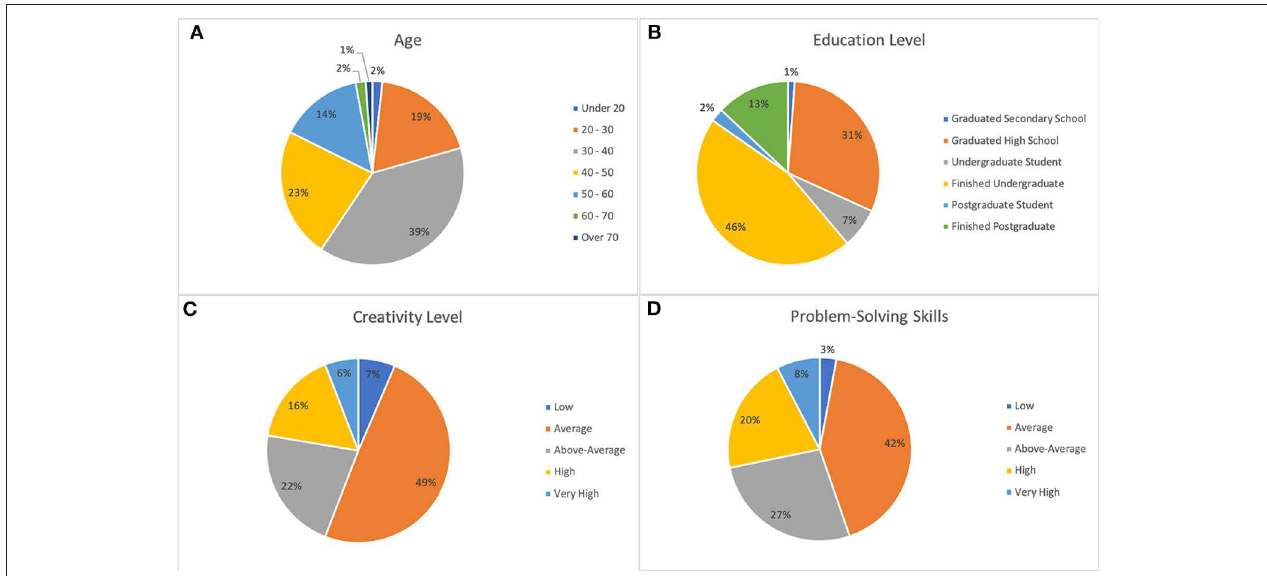
FIGURE 4 | Demographic distribution of Study-2 participants. (A) : Age. (B) : Education level. (C) : Creativity level. (D) : Problem-solving skills.